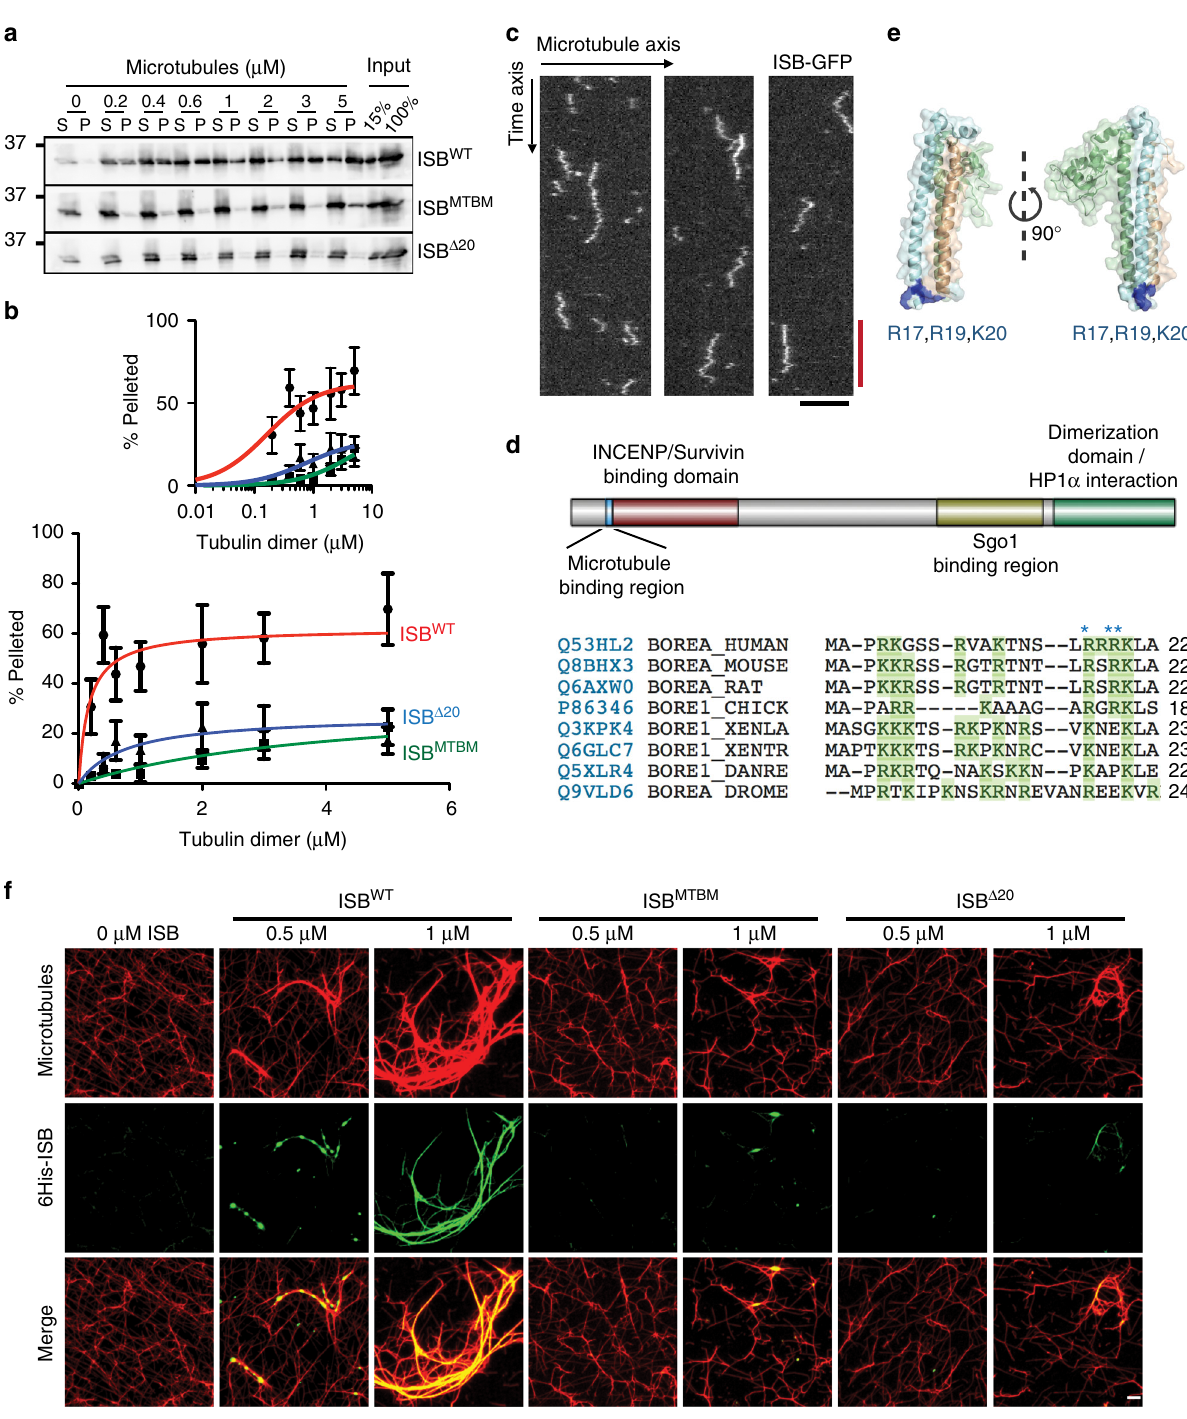
Fig. 1 Borealin binds microtubules through its N-terminal region. a Western blots of input, supernatant (S) and pellet (P) fraction of microtubule co- sedimentation assay with 100 nM ISB WT , ISB MTBM and ISB Δ 20 and indicated concentration of microtubules; probed with anti-Borealin antibody. b Graph from three independent microtubule co-sedimentation assays (mean ± s.d.), small graph is log 10 scale and large graph is linear scale. ISB WT is in red, ISB MTBM is in green and ISB Δ 20 is in blue. c Representative kymographs (from two independent experiments with 150 tracks) of single molecules of ISB- GFP diffusing on taxol-stabilized microtubules, ISF-GFP concentration 100 pM. Black scale bar 5 μ m, red scale bar 1 s. d Schematic showing multiple protein interaction regions on Borealin (microtubule-binding region is characterized in this paper). Multiple sequence alignment of Borealin, basic residues are shown in green, residues important for microtubule binding are indicated with blue asterisk. e Crystal structure of INCENP-survivin-Borealin (PDB: 2QFA); microtubule binding residues R17, R19, and K20 are highlighted in dark blue. f Images from microtubule bundling assay ISB WT , ISB MTBM and ISB Δ 20 were incubated with 1 μ M taxol-stabilized microtubules and probed with anti-tubulin and anti-6His antibody. 6His-ISB is shown in green and microtubules are shown in red (representative images from one of two independent experiments). Scale bar is 5 μ